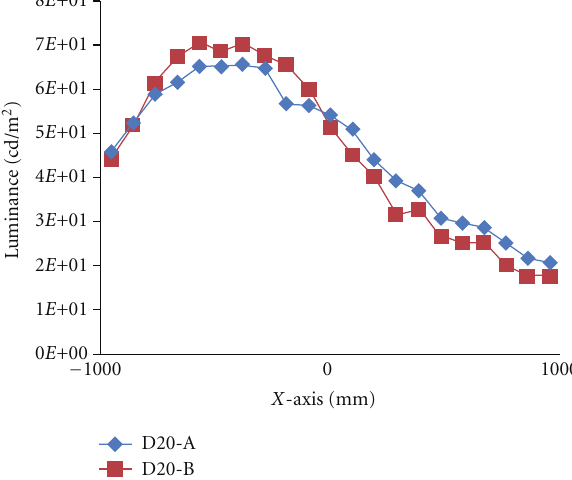
Figure 5: X -axis 2D contour data analysis diagram.